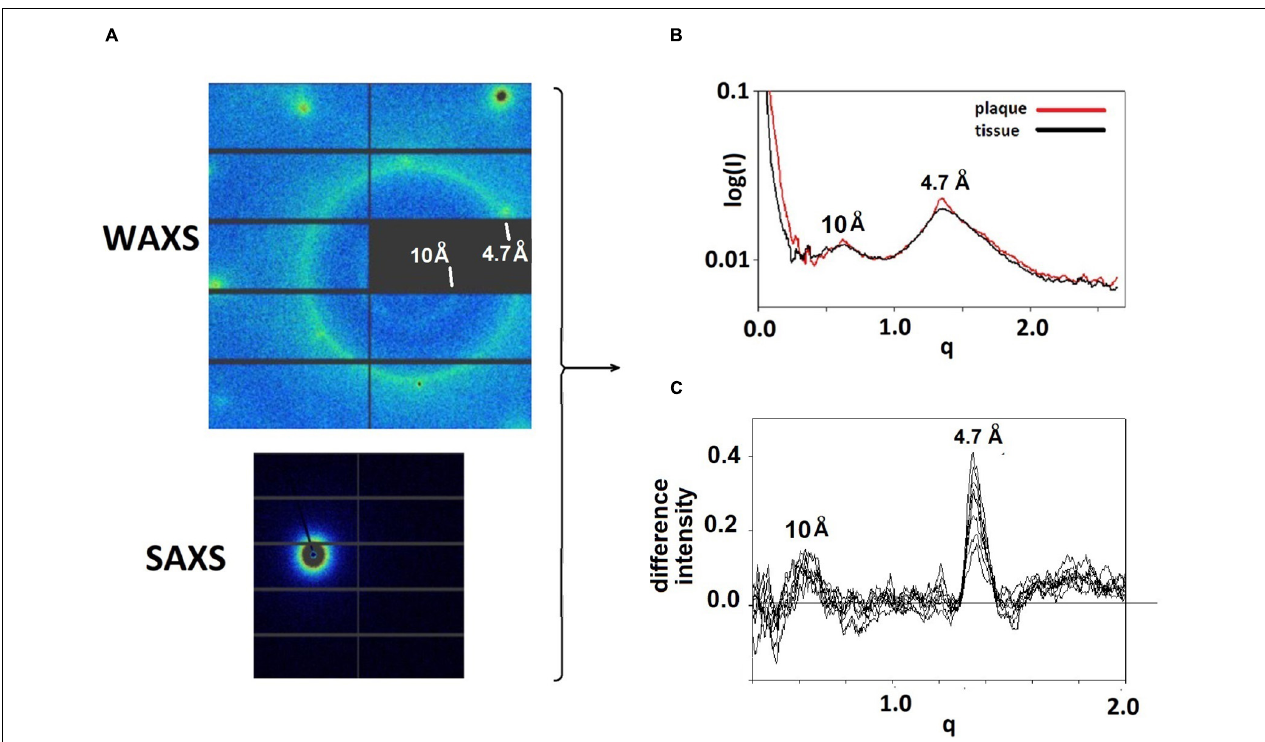
FIGURE 1 | (A) WAXS and SAXS detector images from a pattern taken at the LiX beam line. Relatively sharp reflections at the left and top of the WAXS pattern are from the mica substrate. The strong circle of intensity is at 4.7 Å spacing, the weaker, smaller circle of intensity is at 10 Å spacing. The intensity seen in the SAXS detector is at very small angles and is the most intense in the pattern. (B) The intensities from the SAXS and WAXS detectors are circularly averaged and merged, resulting in scattering patterns that have similar characteristics at most positions in the sample. Regions with a high concentration of fibrillar structures exhibit sharp features at 4.7 and 10 Å spacing. These features can be seen in (C) plots of the difference between scattering from a lesion and scattering from